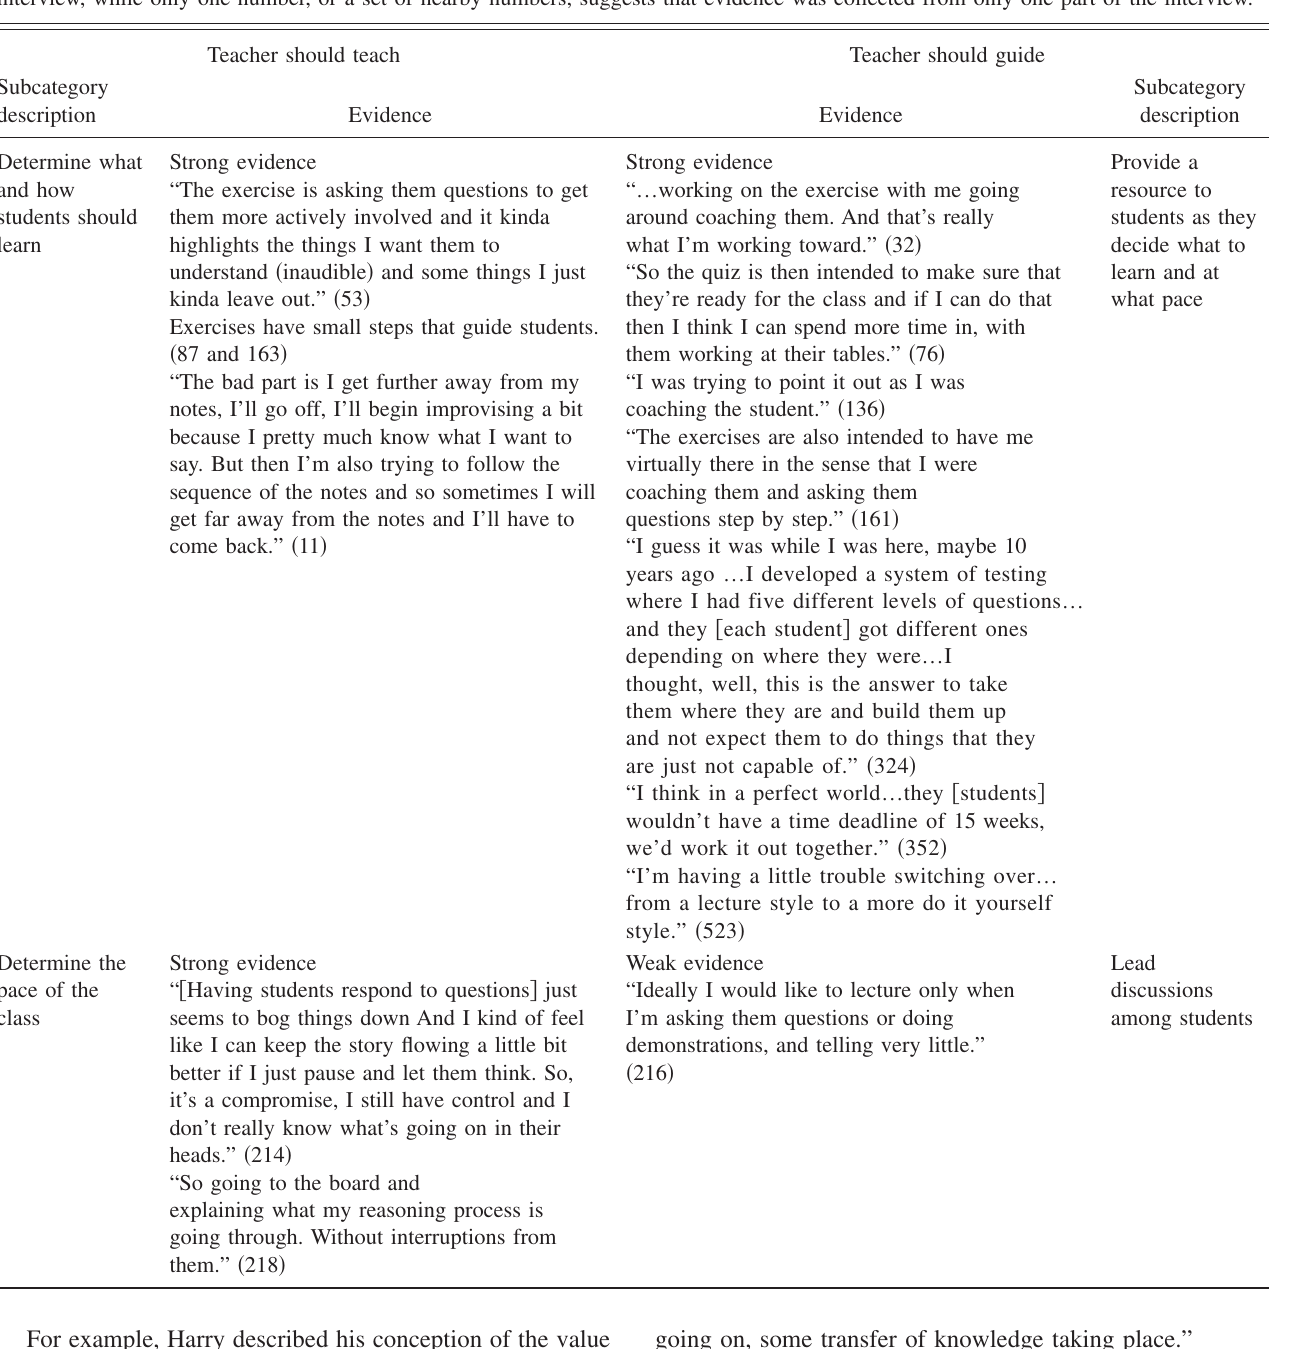
TABLE VI. Example of analysis (cid:1) C7 (cid:2) . Evidence collected from Gary’s interview related to the teacher role category of conceptions. An assessment of the strength of available evidence is provided at the beginning of each cell. Numbers in parentheses indicate line numbers in the interview. Thus, a variety of well-separated numbers in a particular category shows that evidence was collected from multiple parts of the interview, while only one number, or a set of nearby numbers, suggests that evidence was collected from only one part of the